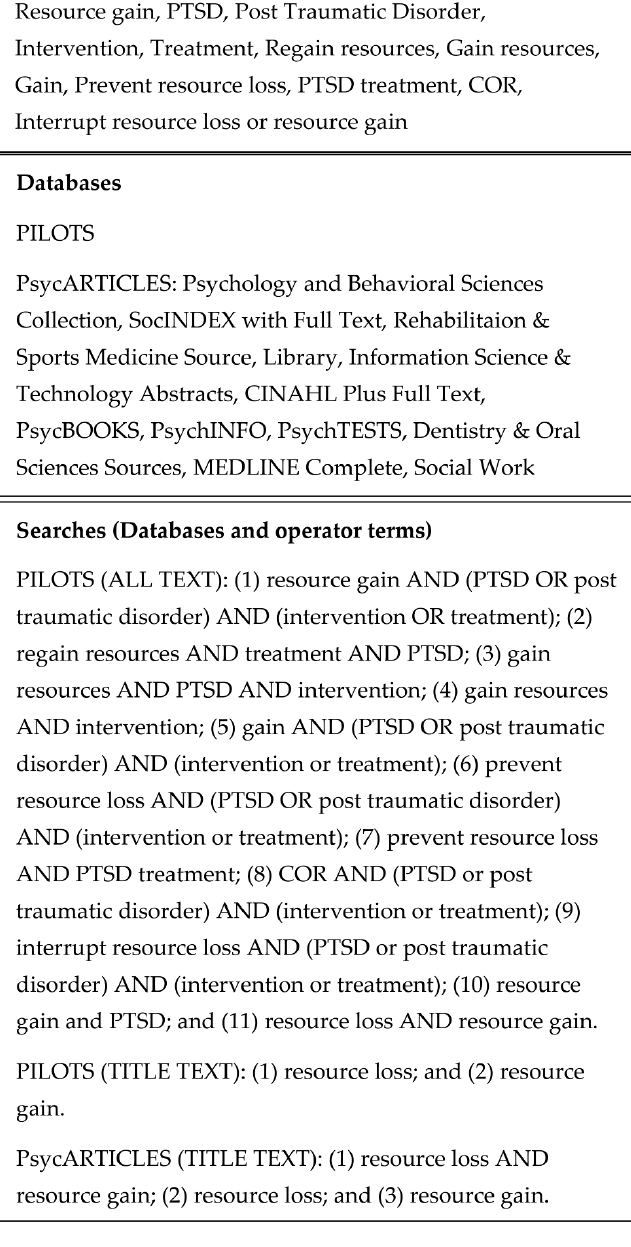
Figure 1. Box about review methodology.